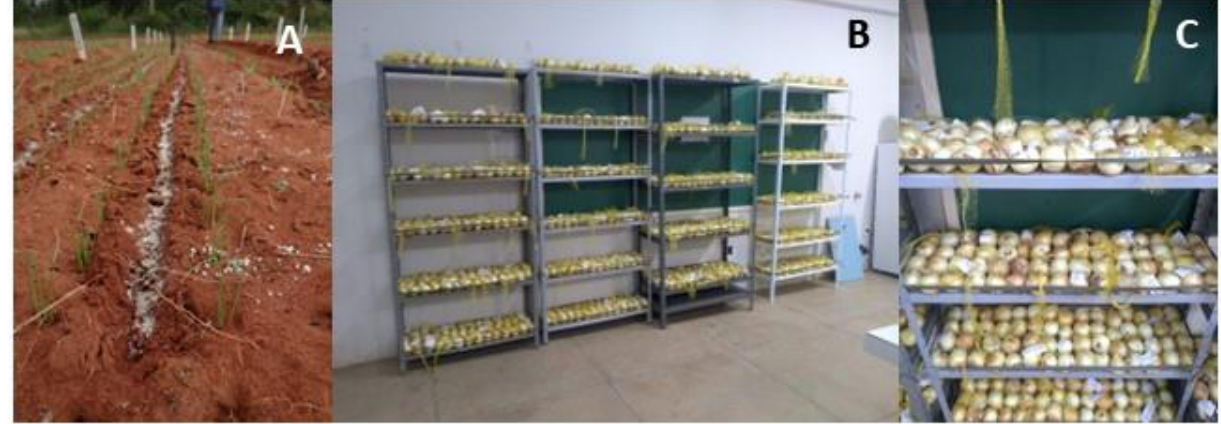
Figure 12. Si-fertilization ( A ) and onion storage ( B , C ).